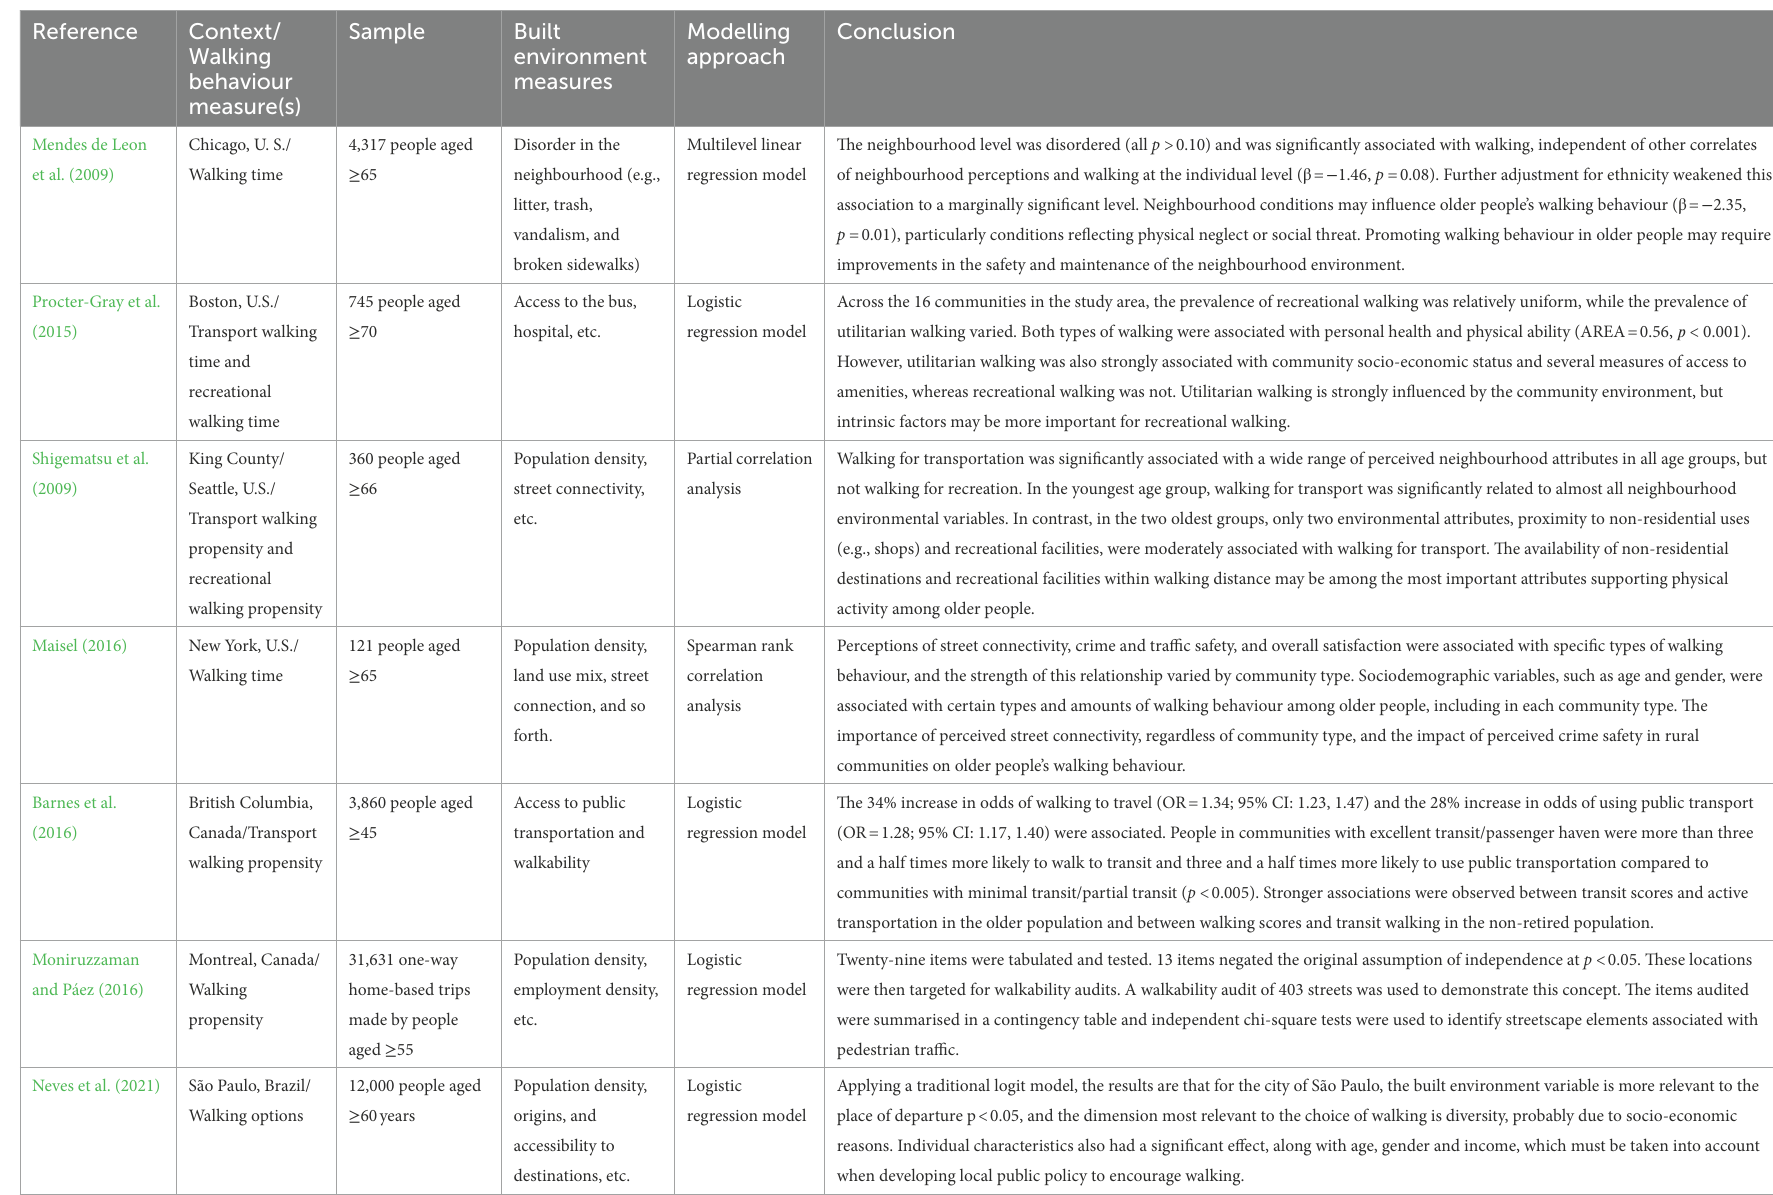
TABLE 1 Summary of studies on the built environment’s effect on walking for older